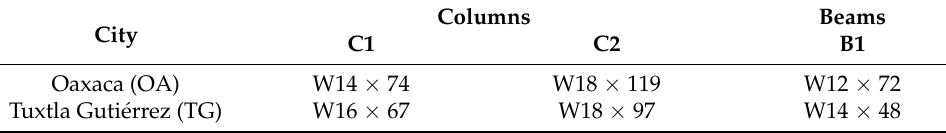
Table 2. Steel W-type sections of the 3-story buildings.